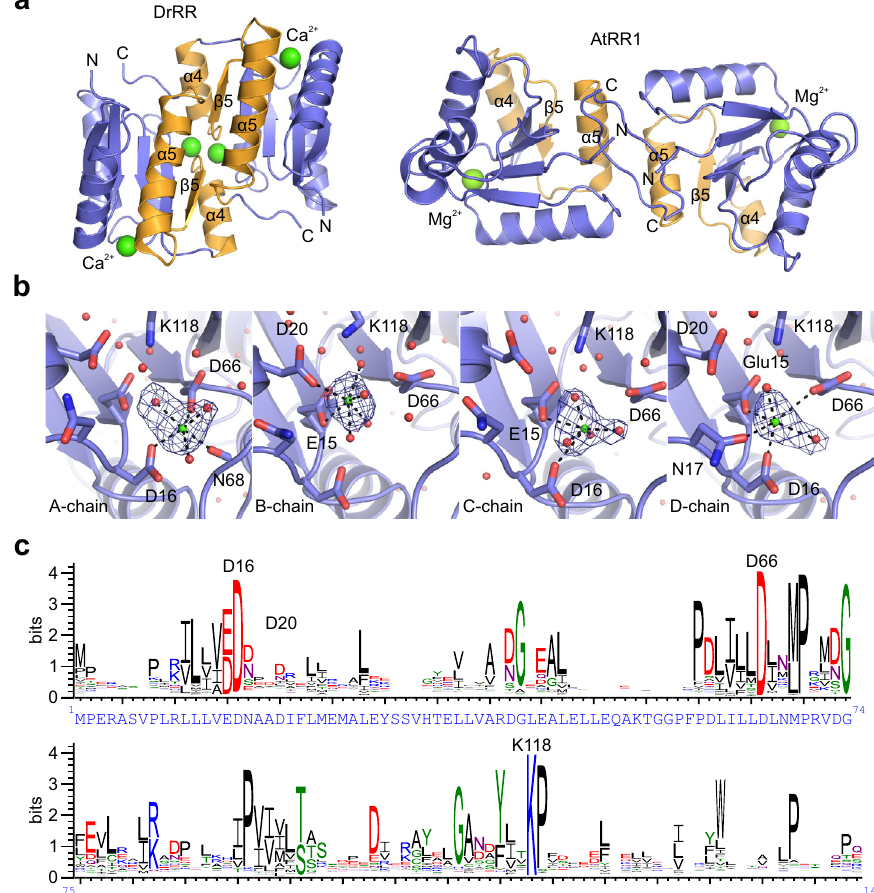
Fig. 4 Crystal structure of the Deinococcus radiodurans response regulator (DrRR). a Cartoon representation of the dimeric DrRR and AtRR1 structures (PDB code 5BRJ for AtRR1 35 ). Both response regulators only consist of receiver (REC) domains. The α 4 – β 5 – α 5 face of each response regulator monomer is shown in orange, and the rest of the protein in blue. Ca 2 + and Mg 2 + ions at the active sites, the N- and C-termini, as well as the dimerization helices are marked. In the case of DrRR, the dimer formed by chains A and B is shown. b The active site of DrRR with its Ca 2 + ions and interacting residues. The localization of the Ca 2 + ions (green) and their interactions (black dashed lines) differ between the chains. The omit difference (F o – F c ) map of the Ca 2 + ions is shown as blue mesh at 5.0 σ . The omit maps were calculated for each monomer by repeating the fi nal re fi nement step without the Ca 2 + ion and the coordinating water molecules. c Sequence logo derived from 50,000 response regulator sequences. The height of each letter indicates the amount of conservation for the corresponding amino acid (one-letter code). The key DrRR residues are shown above the graph, and the full amino acid sequence of DrRR is given below the graph with the same coloring as in panel ( a